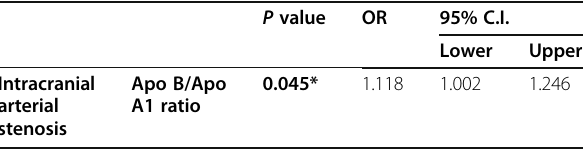
Table 4 Multivariate logistic regression analysis model of Table 5 Multivariate logistic regression analysis model independent factors for intracranial arterial stenosis P value